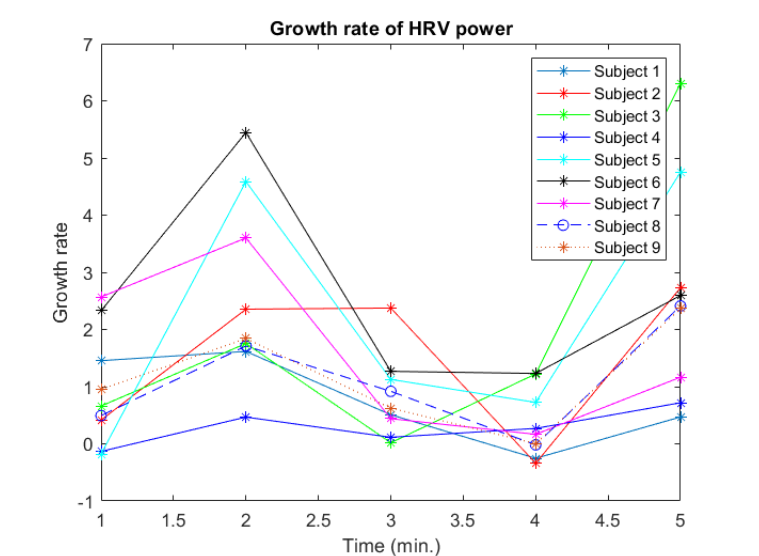
Figure 8. Experiment 2 growth rate of HRV